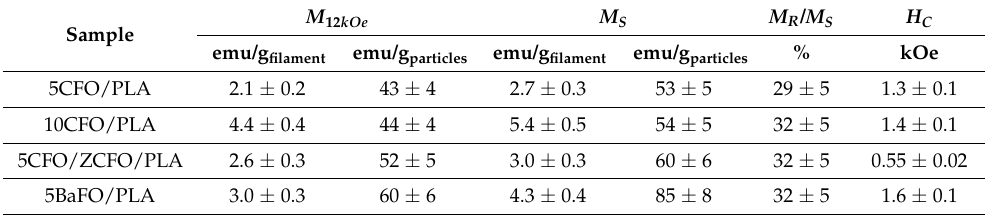
Table 2. Magnetic properties of the filament measured at room temperature: magnetization measured in the 12 kOe field ( M 12 kOe ); saturation magnetization was obtained by extrapolation of the M–H dependences ( M S ), residual magnetization ( M R / M S ), and coercivity field ( H C ). The magnetization values were normalized to the mass of the filament and the mass of the particles contained in the filament according to the nominal particle